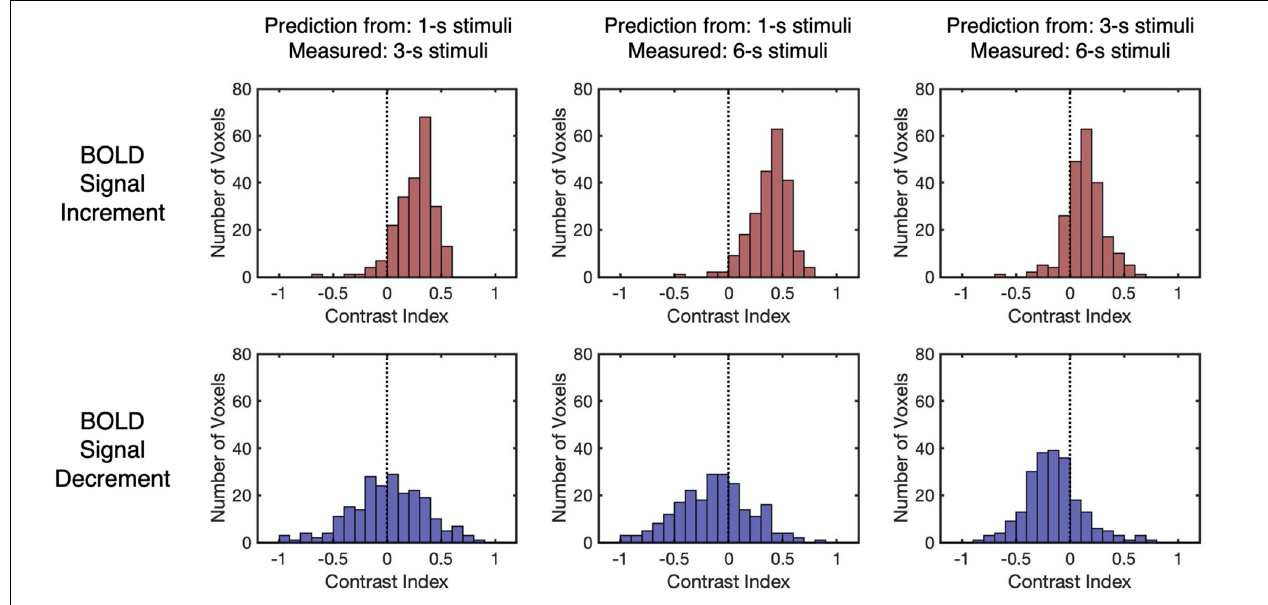
FIGURE 5 | The distributions of the contrast index for different BOLD response types and stimulus durations. The contrast index is close to 0 when linear prediction and measured response have similar amplitudes and is larger (or smaller) than 0 when linear prediction overestimates (or underestimates) measured response. The vertical dashed lines indicate that the contrast index equals 0. Each data point refers to the contrast index of one selected